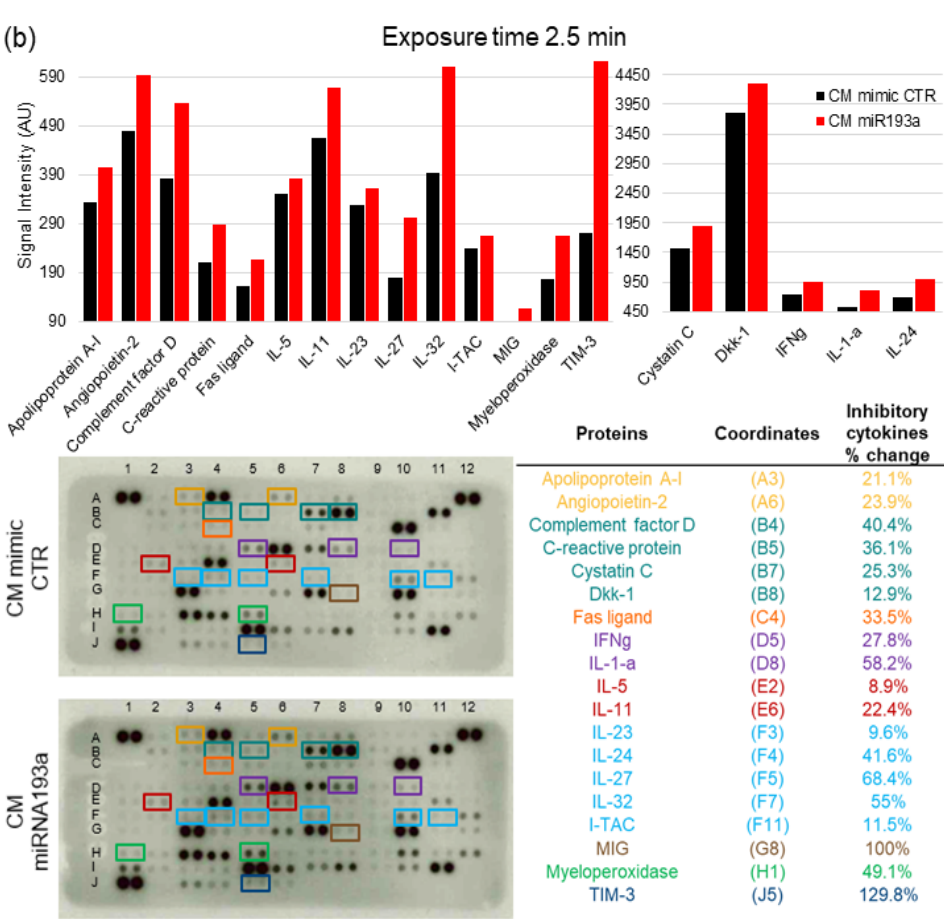
Figure 10. Cytokine(s) expression in MCF-7 secretome is altered by miR193a-3p. Proteome analysis was performed using the Proteome Profiler Human XL Cytokine Array Kit and using equal amounts of conditioned medium (CM) from MCF-7 cells transfected with mimic CTR and miRNA193a (CM miRNA193a). Bar graphs and representative array blots shown are after a short exposure time of 1 min ( a ) and after a long exposure time of 2.5 min ( b ). Images were analyzed using ImageJ after background subtraction. The experiment was performed twice with independent samples. The legend on the right of the array blots depicts inhibitory cytokines and the coordinates for their location on the blots in colors.